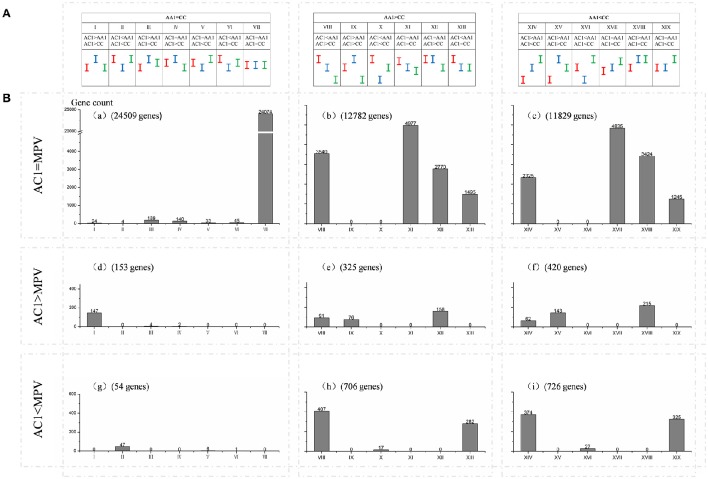
Global classification of gene expression among hybrid AC1 and its progenitors. Genes based on differentially or non-differentially among the hybrid, diploid progenitors, and MPV, were further classified into (A) 19 possible expression patterns (I—XIX; AA1 vs. CC, AA1 vs. AC1, AC1 vs. CC) and (B) 9 major expression categories (a–i; AC1 vs. MPV, AA1 vs. CC). Red, green and blue bars represent the confidence intervals of expression level observed in A and C genome progenitors and hybrid, respectively. Genes are differentially expressed between two samples when their confidence intervals (bars) do not overlap whereas it is equal when they do overlap. The x-axis represents the 19 possible expression patterns. The y-axis represents gene count. The number of genes for each expression pattern in each of expression categories is also indicated.